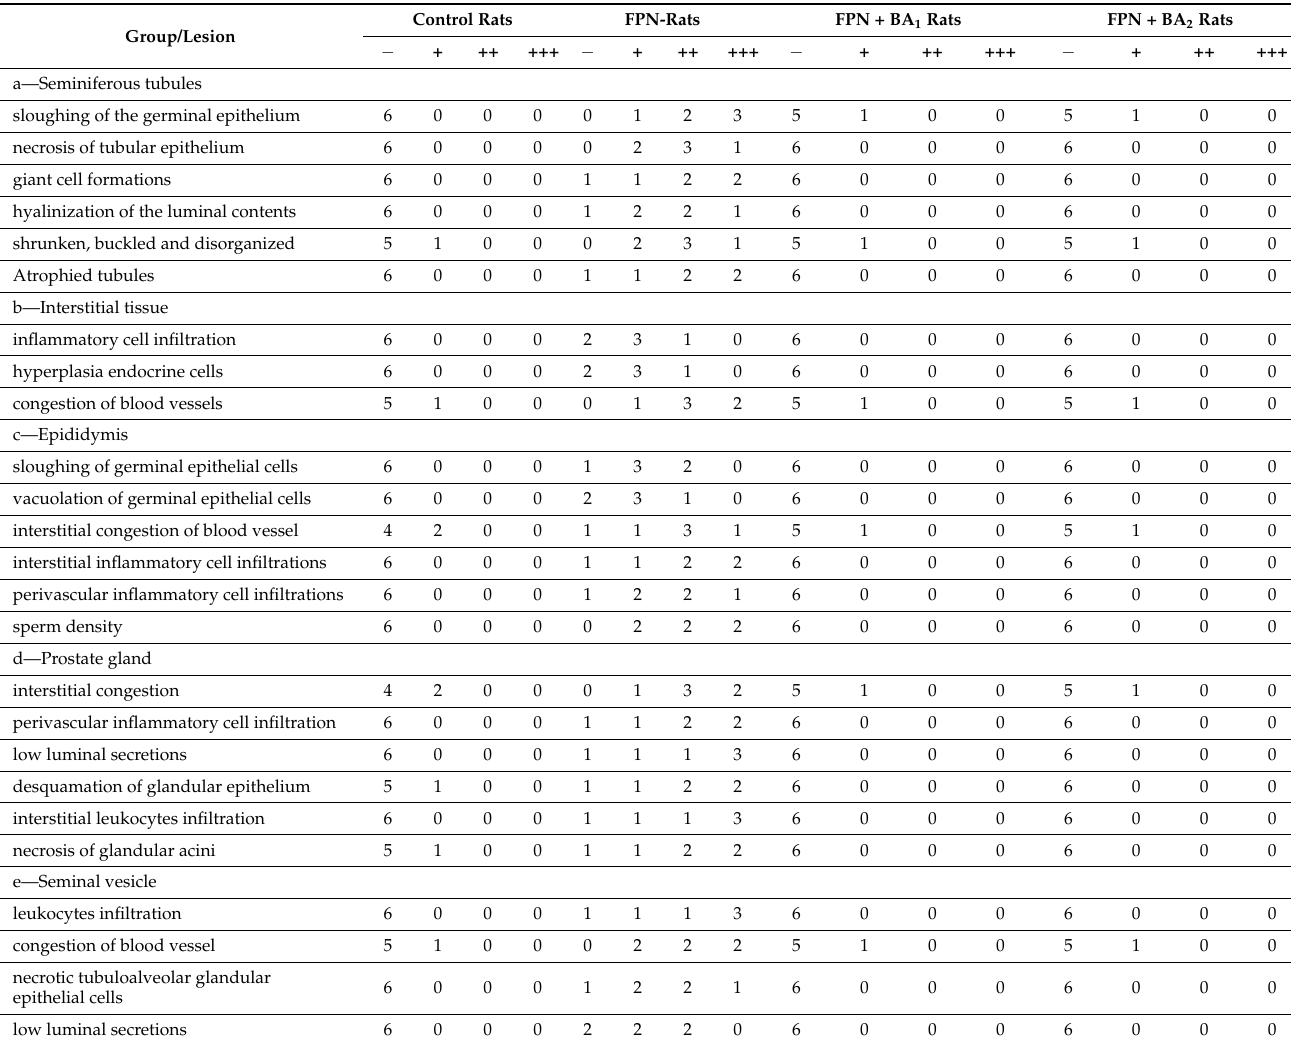
Table 6. Incidence and severity of histopathological findings in the examined tissue of fipronil and co-treatment with boswellic